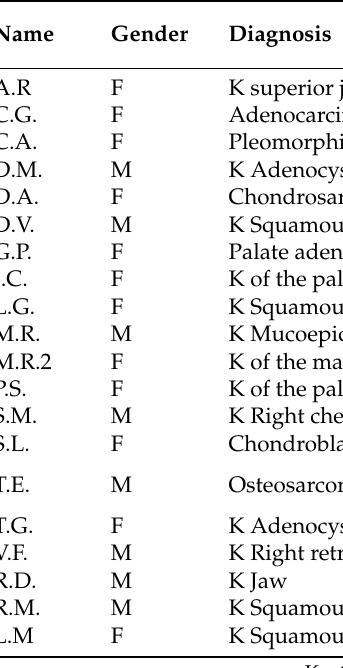
Table 1. Evaluation of 20 patients with primary oral cancers.